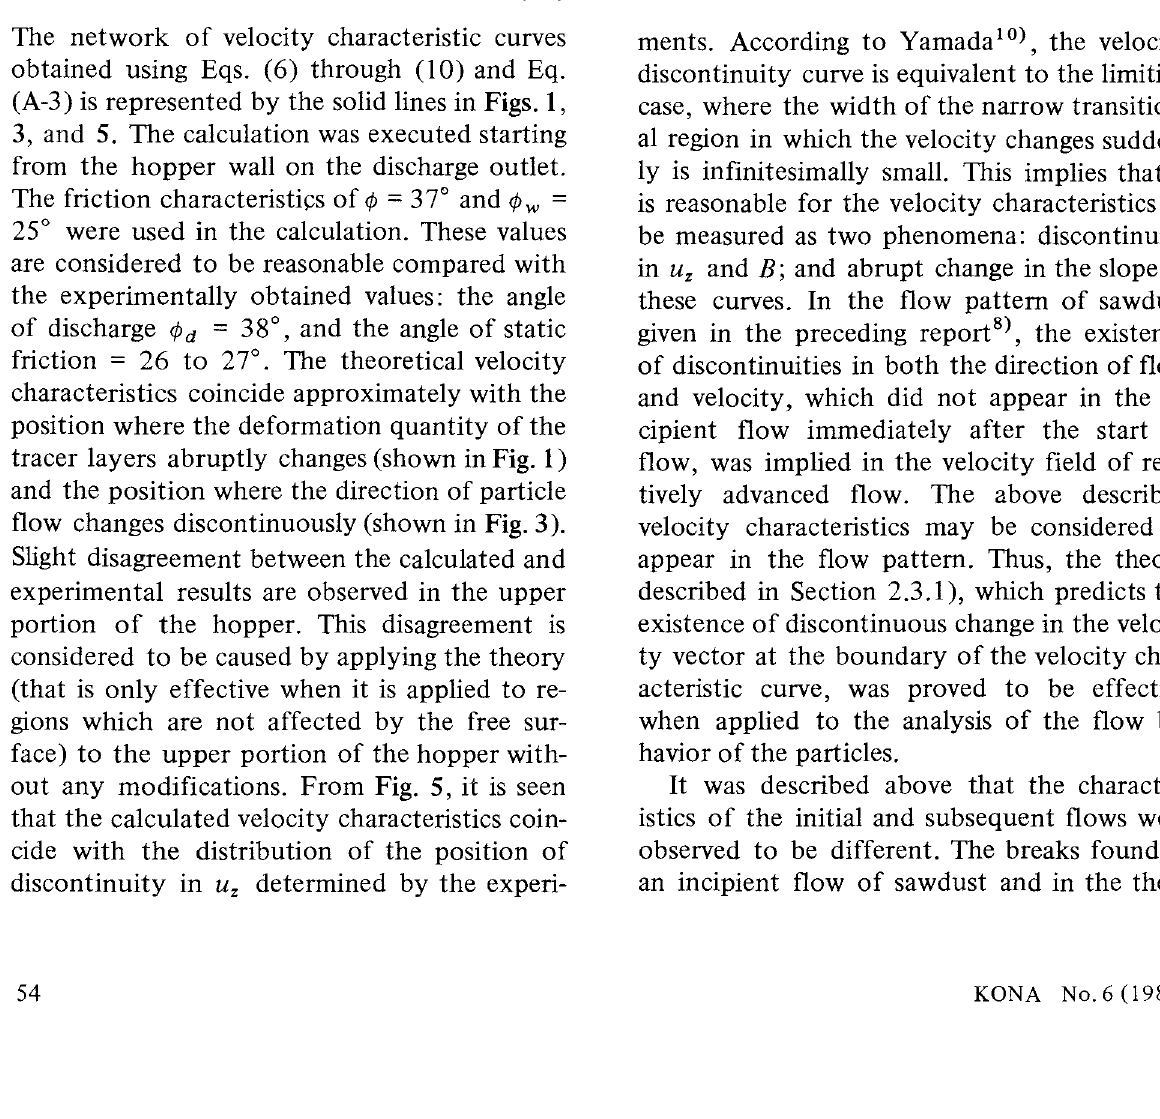
Fig. 7 Comparison between the breaks found at incipient flow of sawdust 8 ) and theoretical slip